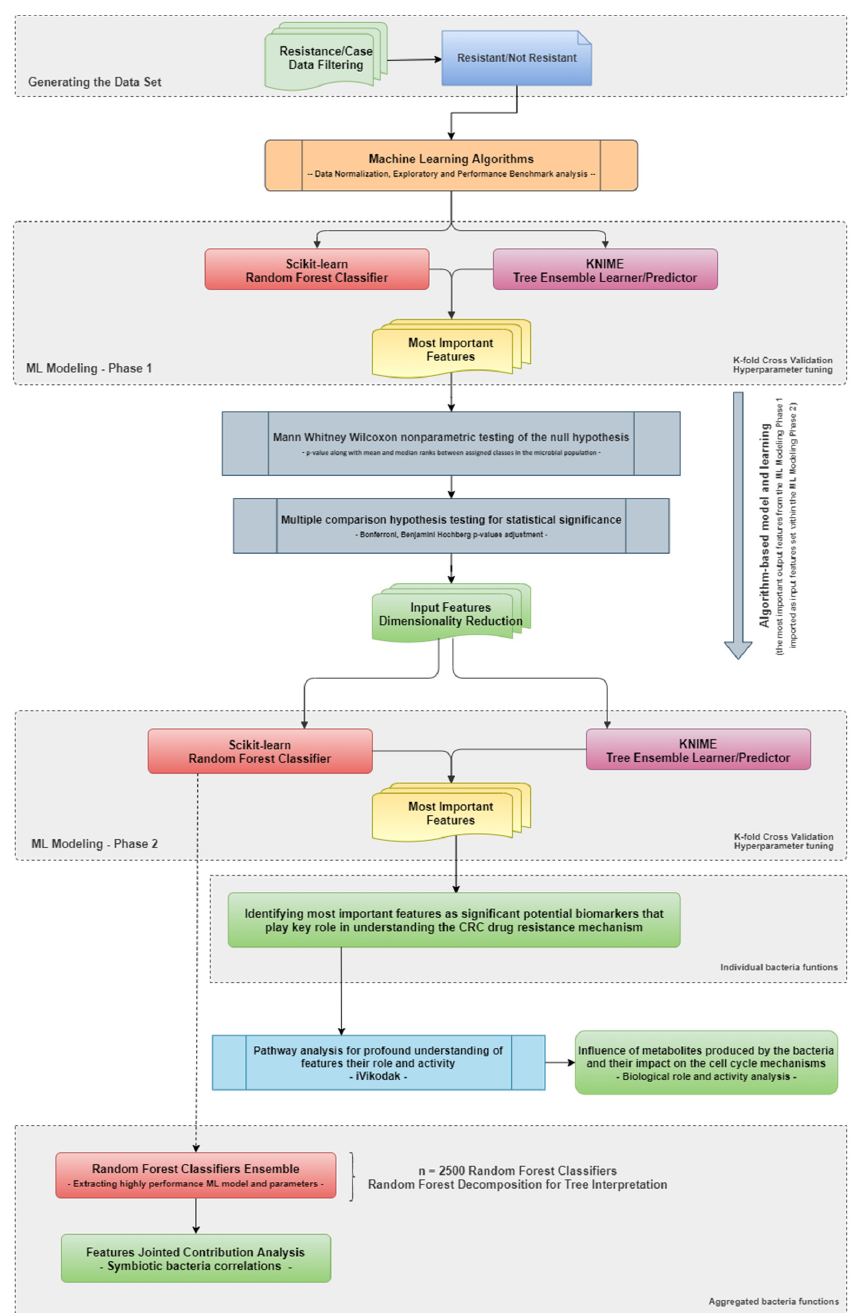
Figure 3. Study methodology diagram for modeling and interpreting the key biomarkers that